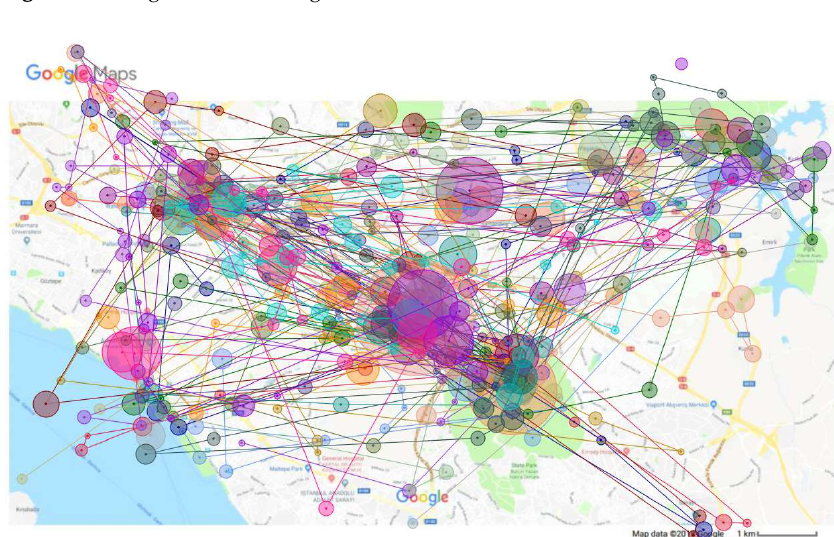
Figure A6. Larger version of Figure 8f.